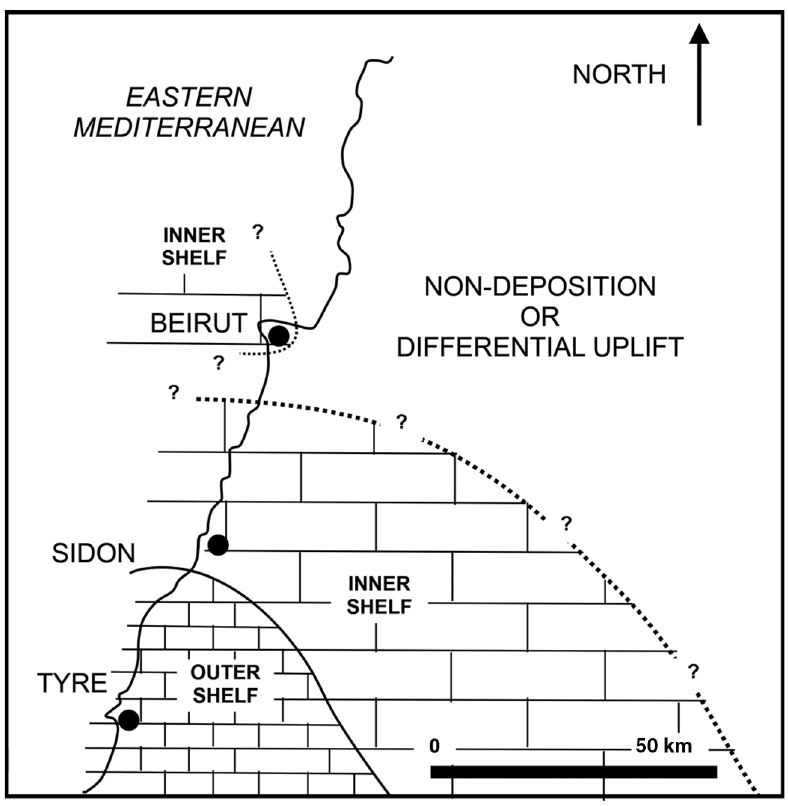
reviewed Priabonian environment of deposition from BouDagher-Fadel and Noujaim Clark [1] in light of the present- day description of its environment of deposition in the harbour